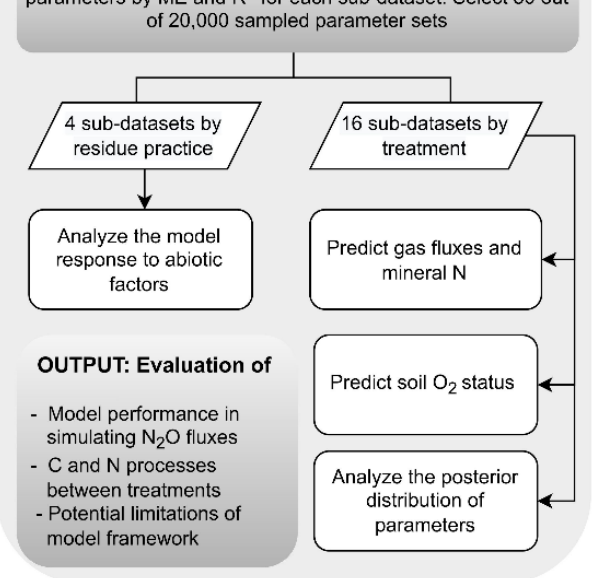
Figure 2. A schematic diagram of the workflow of the study to ana- lyze parameter sensitivity and uncertainty of the CoupModel based on 16 treatments from an incubation experiment (see text for de-